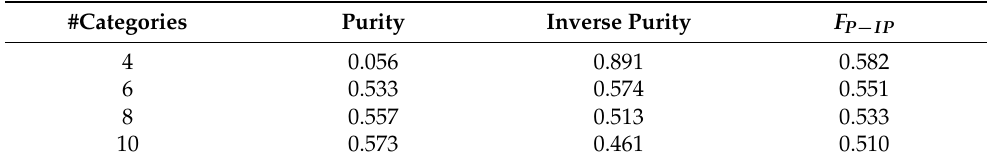
Table 2. Accuracy of issue ticket categorization.